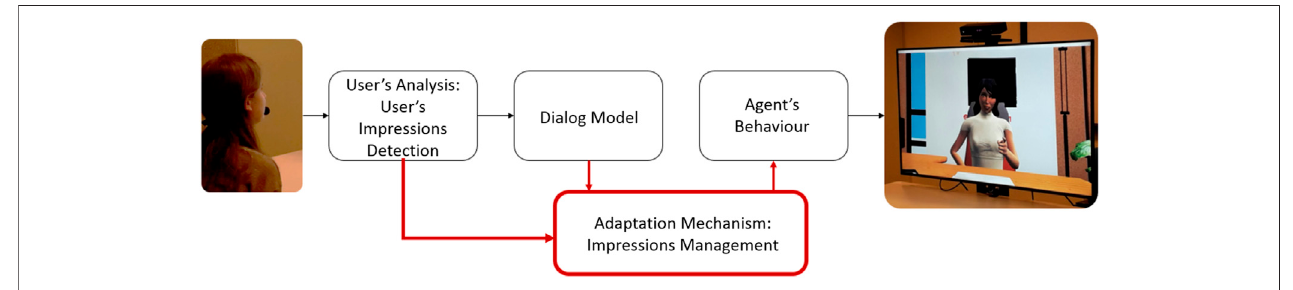
FIGURE3 | Modi fi ed systemarchitecture used inStudy 1. In particular, theUser ’ s Analysismodule contains themodel to detect the user ’ simpressionsfrom facial signals. The Impressions Management module contains the Q-learning algorithm.